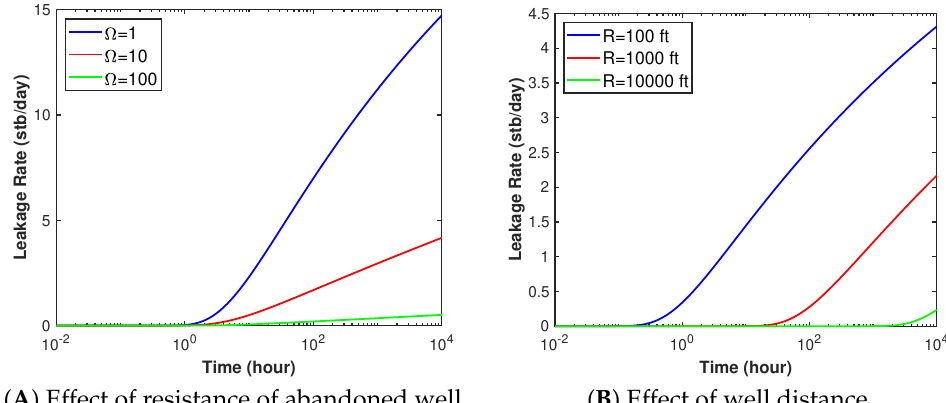
Figure 9. Comparison of leakage rate profiles with different flow resistances in the abandoned well ( A ) and different well spacing ( B